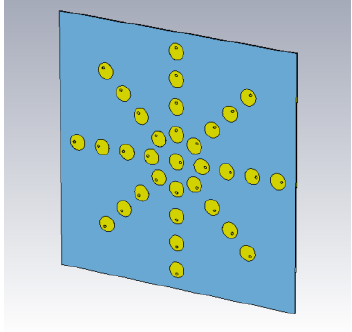
Fig. 2. A model of a micro strip antenna designed in CST STUDIO